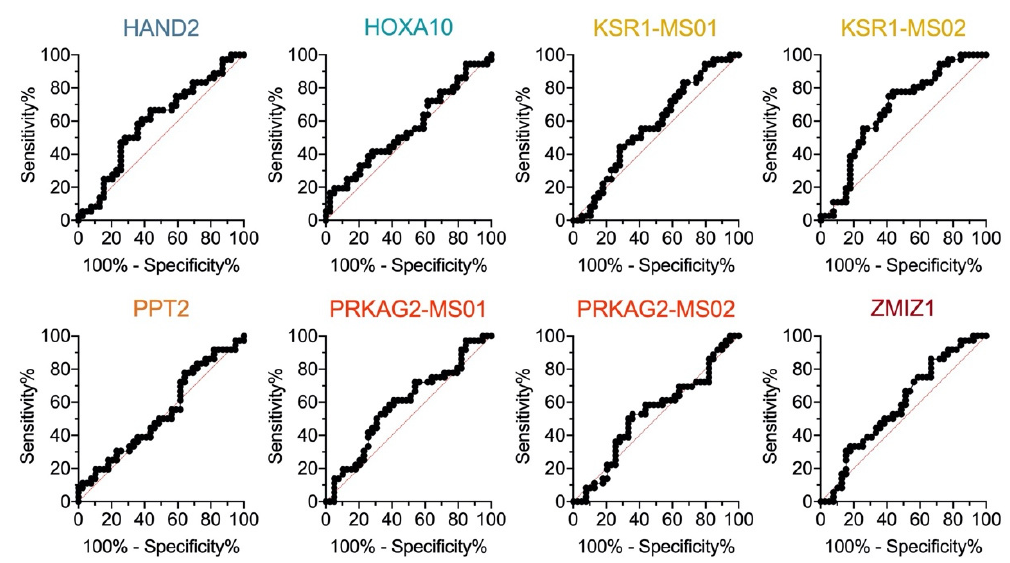
Figure 3. The methylation status in cervical secretion samples from 36 pregnant and 36 non ‐ preg ‐ nant subjects with qMSP. * p < 0.05.